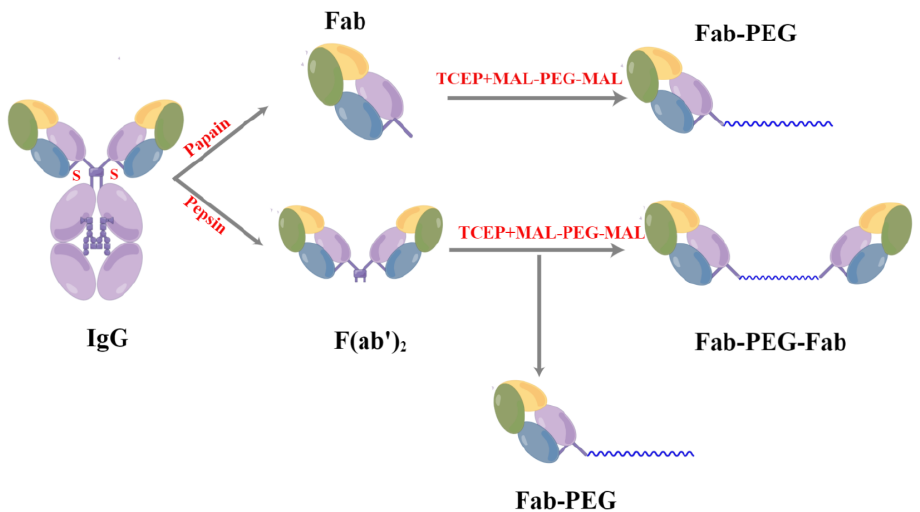
Figure 1. Structural representation of IgG, F(ab’) 2 , Fab-PEG, and Fab-PEG-Fab and the preparation process of PEGylated F(ab’) 2 . On the one hand, IgG was digested by pepsin to obtain F(ab’) 2 . F(ab’) 2 was restored to Fab’ by TCEP and bound to 10 KDa MAL-PEG-MAL immediately. Fab-PEG and Fab-PEG-Fab were obtained. On the other hand, IgG was digested by papain to obtain Fab, and Fab bonded to 10 KDa MAL-PEG-MAL to obtain Fab-PEG.